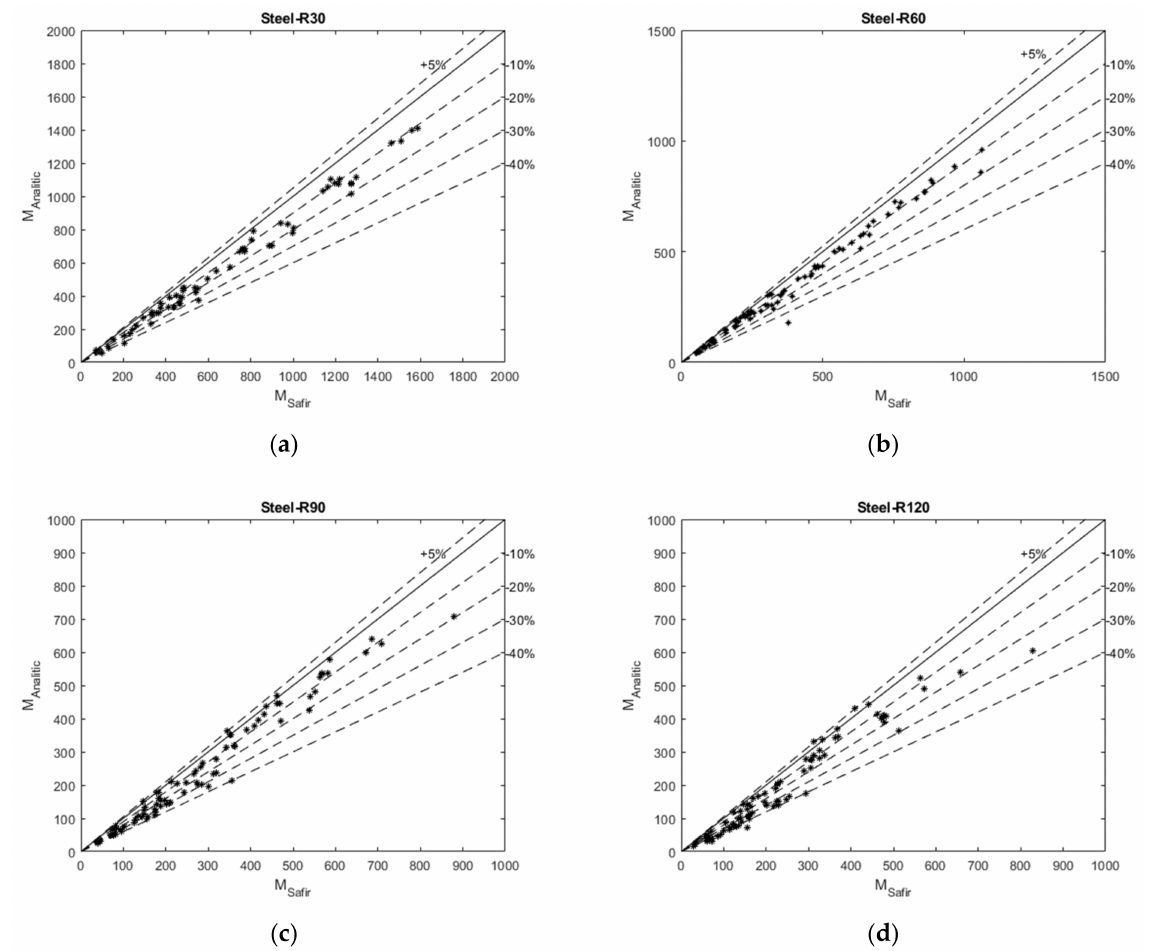
Figure 12. Comparison of bending resistance for non-composite behavior of studied configurations— analytical model vs. FEM: ( a ) R30; ( b ) R60; ( c ) R90; ( d ) R120.